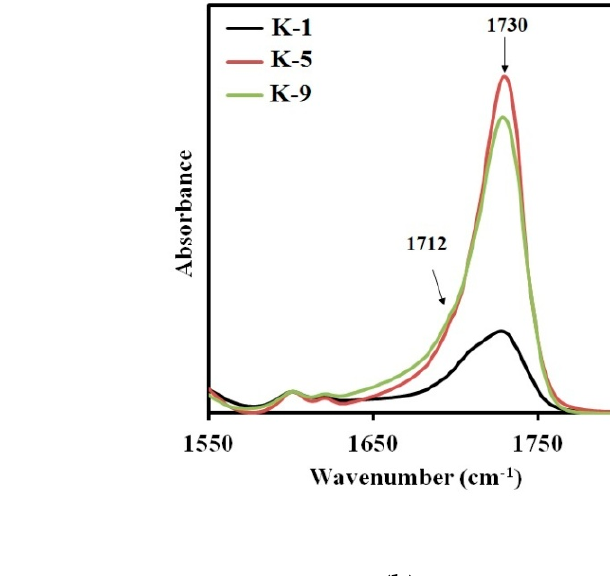
( b ) Figure 8 . Sections of the FTIR spectra for the samples: ( a ) K–4, K–8, K–12; ( b ) K–3, K–7, K–11.